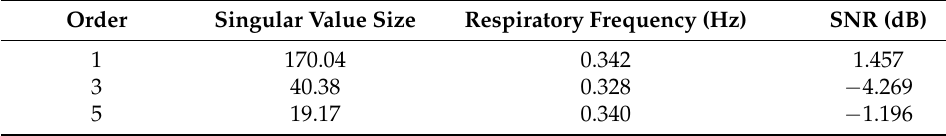
Table 2. Respiratory signal restoration